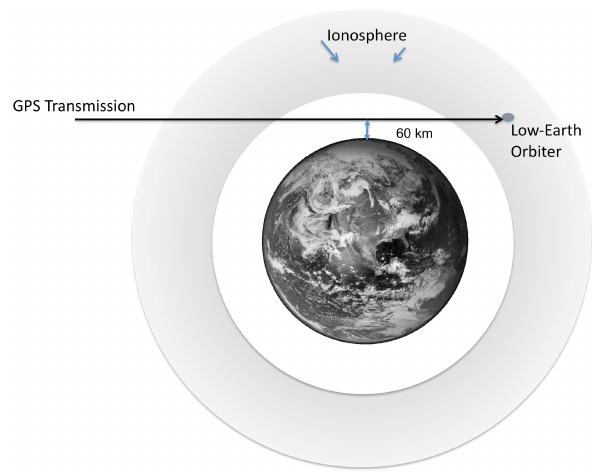
Fig. 3. Schematic representation of the simulated raypath as it en- ters, exits then re-enters the ionosphere before meeting with the re- ceiver.